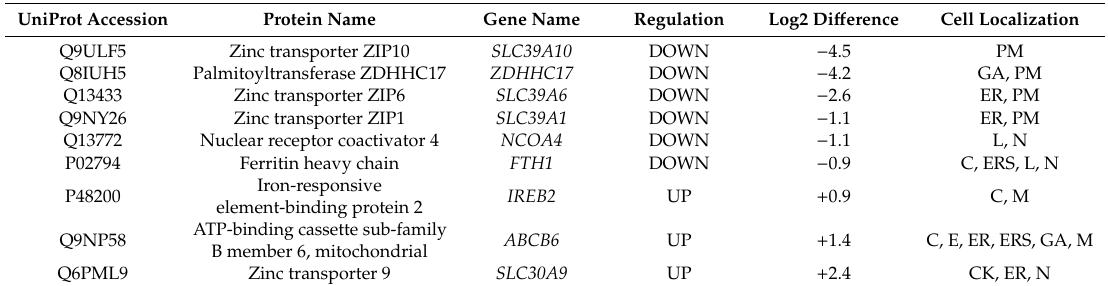
Table 4. Dysregulated proteins in MUT-KO involved in metal